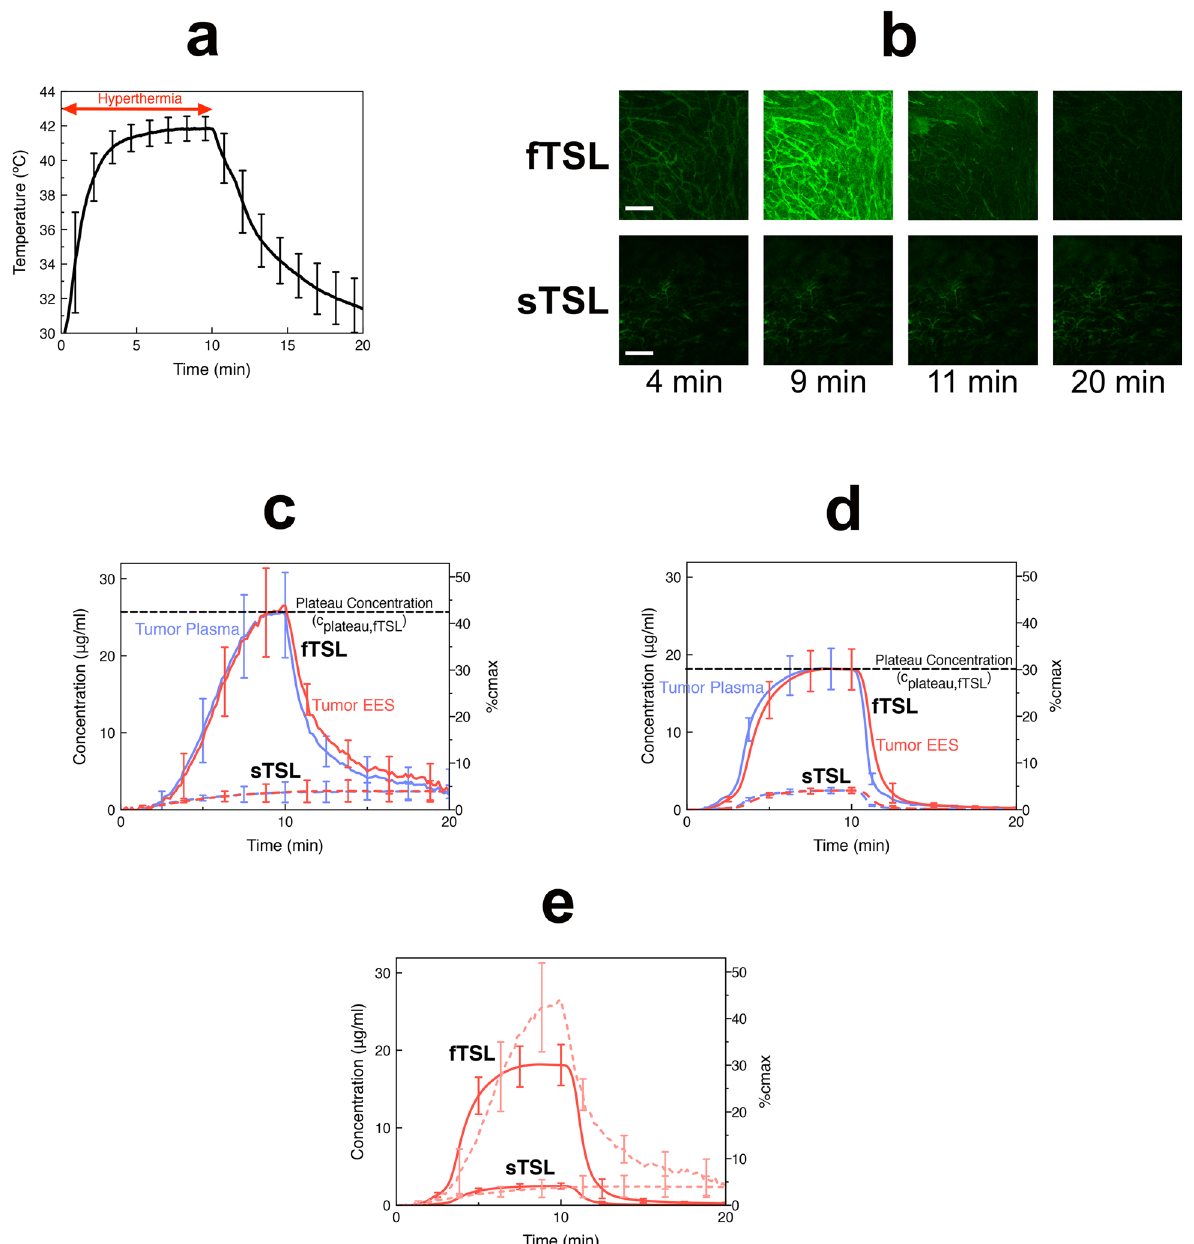
Fig. 4 IV-DDS delivery kinetics in vivo and in computer model. a Tumor temperature during hyperthermia exposure (41 – 42 °C) after administration of either sTSL or fTSL fi lled with fl uorescent dye (carboxy fl uorescein(CF)). Temperature was sampled every 2 s. b Intravital microscopy at 4 min visualizes intravascular release starting at ~40 °C, visible because of dequenching of dye fl uorescence when released from TSL. Tissue uptake is highest just before heating stops (9 min), with rapid washout once heating has been discontinued (11 min). The whole image time series for sTSL and fTSL are available as Suppl. Movies 2, 3. Scale bar indicates 200 μ m. c In vivo plasma and EES concentration time courses indicate that fTSL (solid curves) are about ten times more effective than sTSL (dashed curves). Graph shows mean concentrations in imaged tumor segment derived from intravital image data (image acquisition every 10 s). Error bars indicate standard deviation ( n = 3 animals for both sTSL and fTSL). d Computer models based on in vivo tumor transport parameters and considering temperature-dependent TSL release time based on in vitro measurements. Error bars indicate model uncertainty due to uncertainty of model parameters. e Direct comparison of tumor EES concentration between computer model (solid curves) and intravital data (faint dotted curves). The peak concentration (plateau concentration ( c plateau )) in plasma and EES, indicated for fTSL by a black dashed line in c , d depends on TSL release time. Both in vivo studies and computer simulation demonstrate about ×10 higher ef fi cacy (based on plateau concentration) of fTSL compared to sTSL (Table S1). The right-side y -axis in c – e displays the fraction of maximum possible drug uptake ( c max ) achieved. This maximum concentration ( c max ) is equal to the systemic plasma concentration of IV-DDS encapsulated drug. fTSL release was about 8 times as fast as for sTSL (see Table